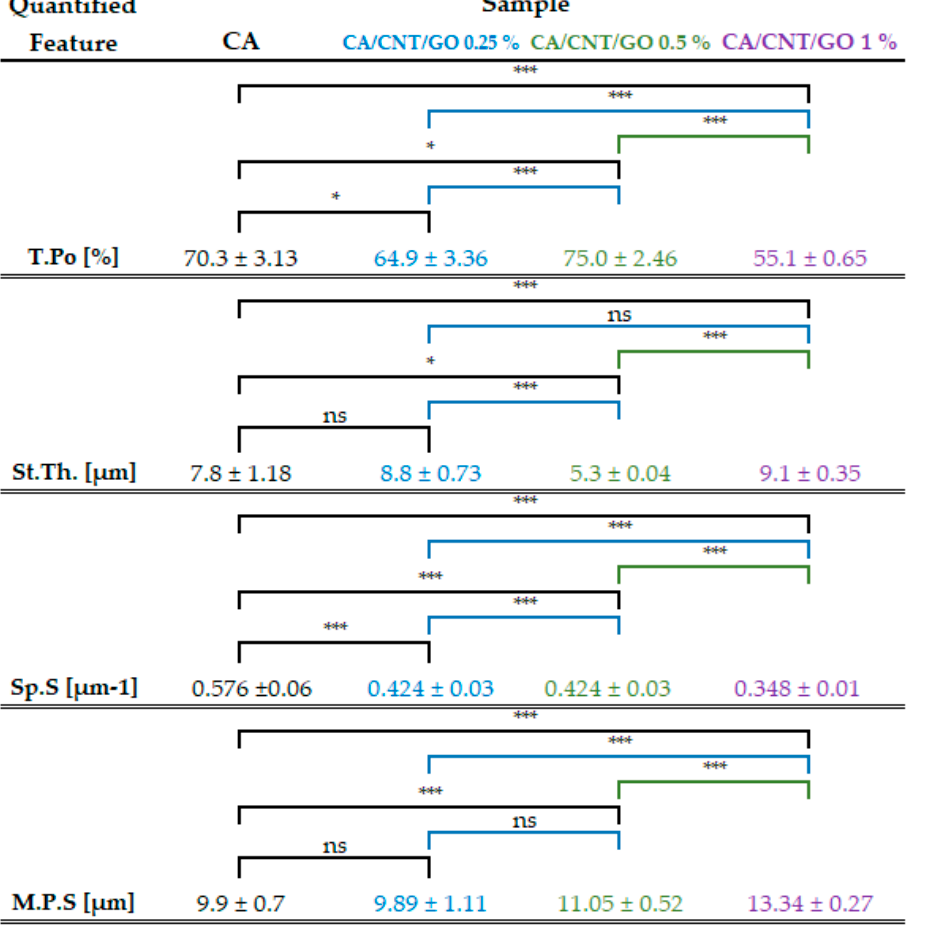
Figure 2. Tabulation of the calculated values for total porosity (T.Po), structure thickness (St.Th), and specific surface (Sp.S) appraised as the ratio of object surface and object volume and mean pore size (M.P.S.). The values were averaged after 3D analysis carried out in CTAn for 4 distinct proportionate volumes of interest (VOIs) per composite sample. Standard deviation and statistical significances are illustrated related to the CA control and each CNT and GO addition. (* p < 0.05; *** p < 0.001; ns p > 0.05).